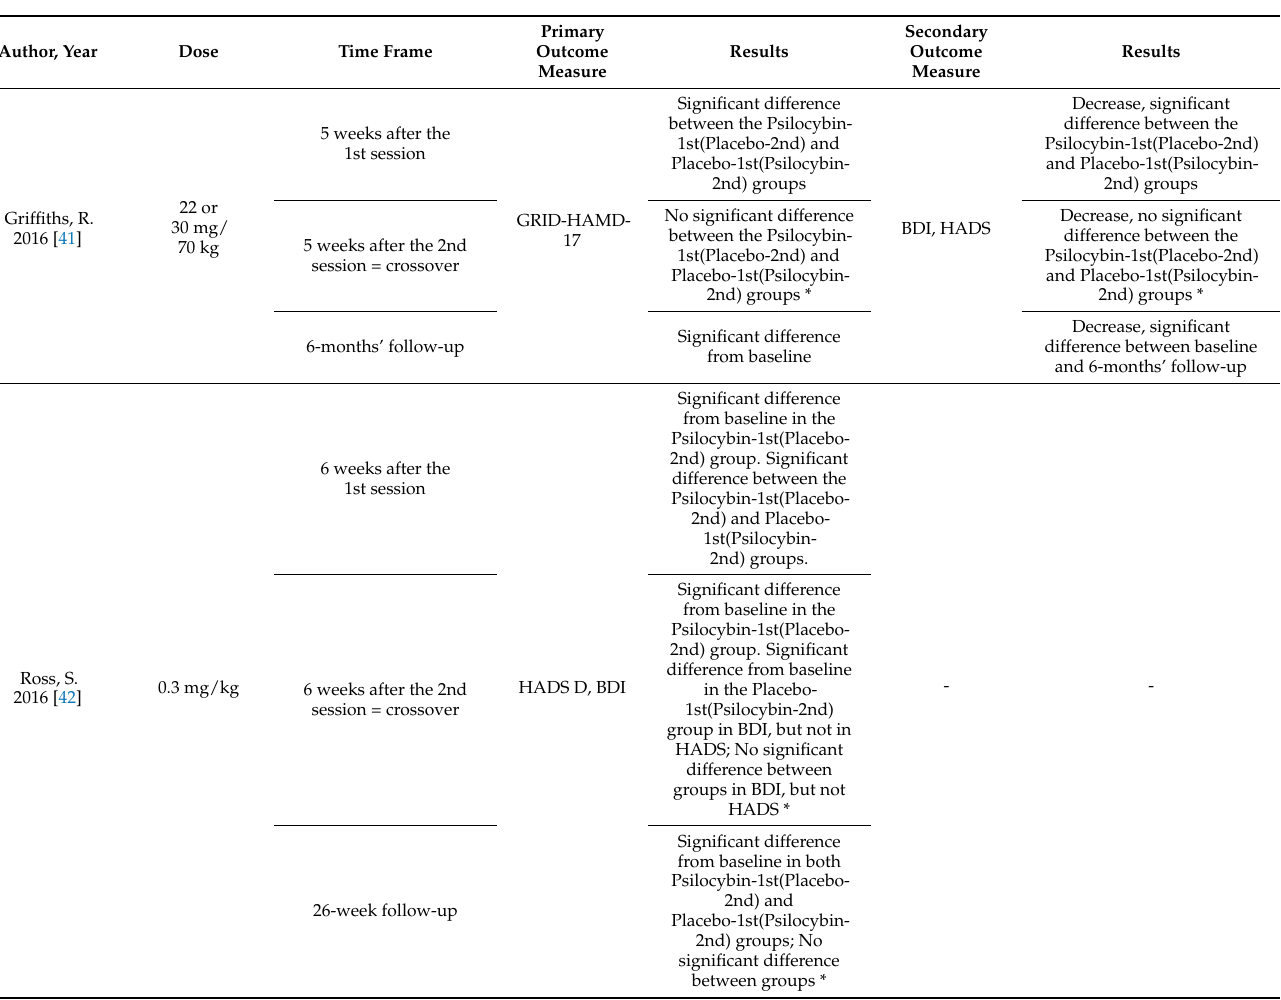
Table 5. Antidepressant effects of